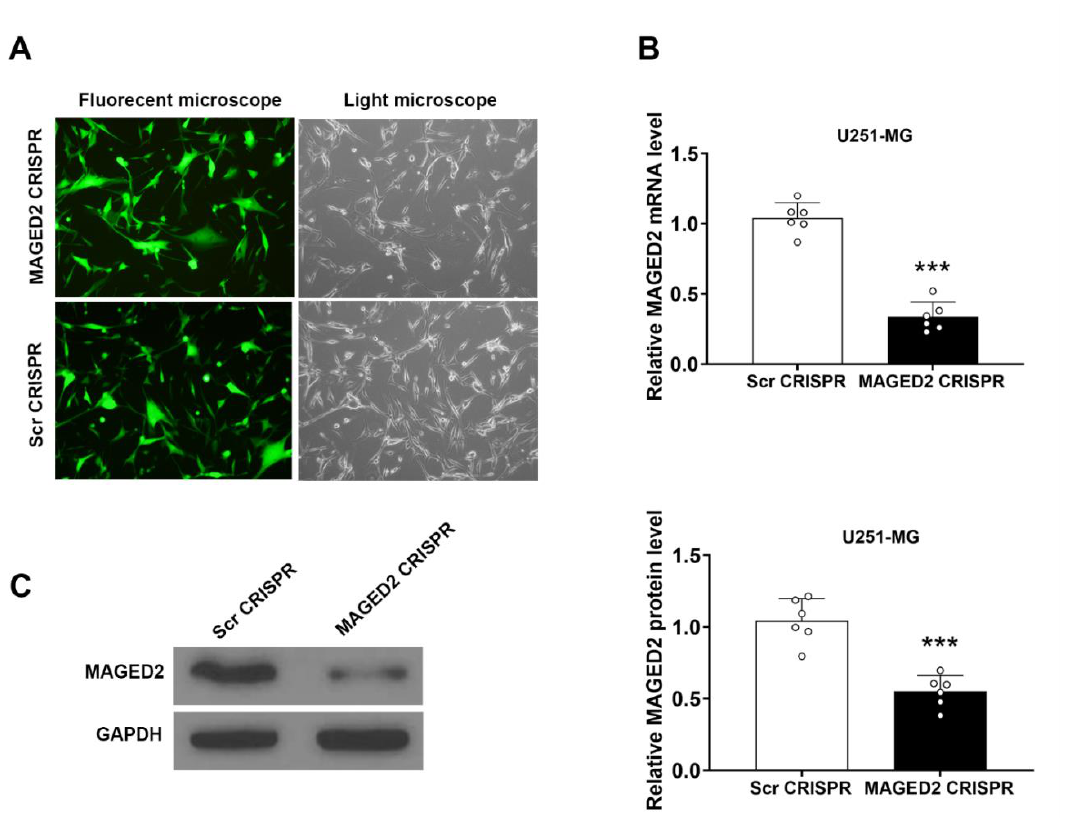
Figure 5. The glioma U251-MG cells were transfected with a lipofectamine vector expressing the MAGED2 CRISPR. ( A ) Fluorescence microscopy is used to assess transfection effectiveness 72 h after transfection. qRT-PCR test is used to determine the knockdown effectiveness of MAGED2 ( B ) and Western blotting ( C ). *** p < 0.001 compared with the Scramble CRISPR group; n = 6/group.